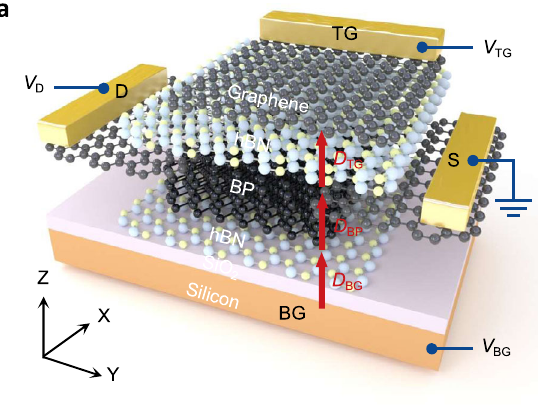
Fig. 1 | Device con fi guration and measurement scheme. a Schematic view of a and BS represent the movable mirror, stationary mirror, and beam splitter, typical dual-gate BP transistor. Top and bottom gate voltages ( V TG and V BG , respectively. Photocurrent spectrum (top right) which is obtained from inverse respectively) are applied to control the carrier density and electric displacement fi eld in the sample ( D BP ). b Illustration of the interferometer setup where M1, M2,